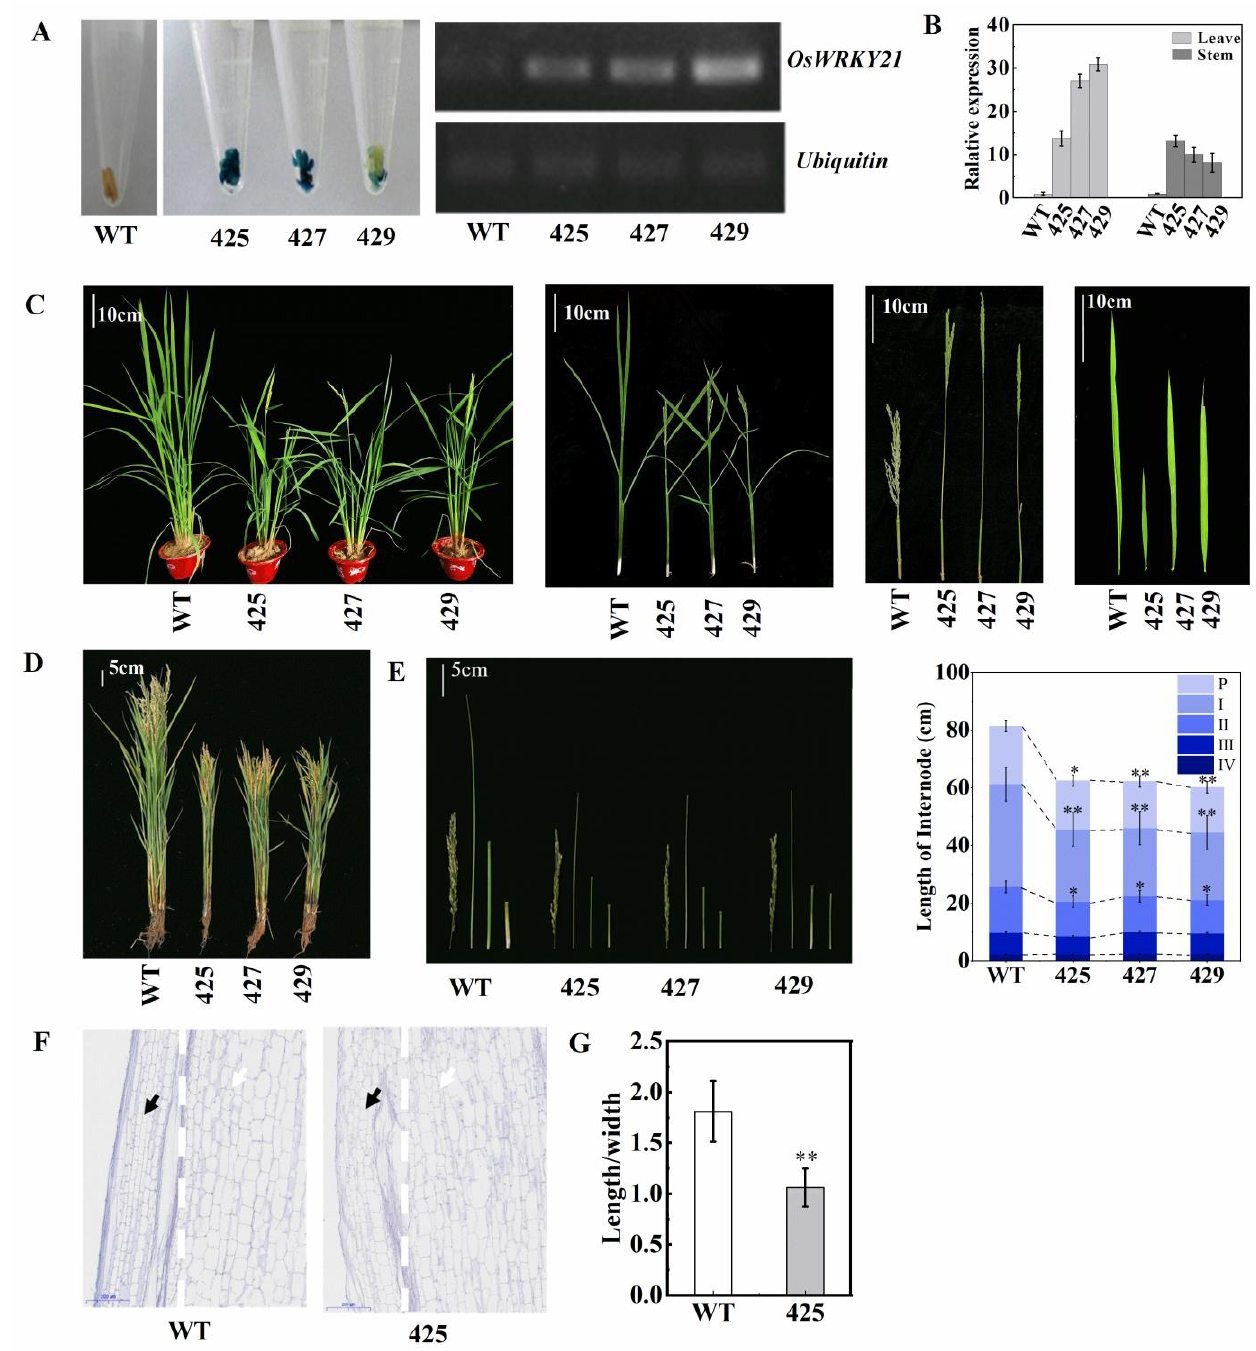
Figure 3. Generating and Characterization of OsWRKY21 transgenic plants . ( A ) GUS staining and semi-quantitative RT-PCR to select positive transgenic lines (425, 427 and 429). The positive OsWRKY21 OE lines were in blue with the GUS staining. Gene Ubiqutin was used as the internal control in RT-PCR analysis. ( B ) Relative expression of OsWRKY21 in the wild-type ZH11 and the OE plants using qRT-PCR. ( C ) Phenotypes of the wild-type ZH11 and three OE lines (425, 427 and 429) at heading stage, scale bar = 10 cm. ( D ) and ( E ) Lengths of the panicles and internodes of wild-type ZH11 and OE plants at maturity stage. P, panicle; I, the uppermost internode; II, III, IV, the second, third, and fourth internodes counted from the up to bottom, respectively. (* and ** indict p -value < 0.05 and 0.01, respectively, t -test, n = 15). ( F ) and ( G ) Comparison of the longitudinal sections of the second uppermost internodes of WT and line 425, scale bar = 200 µ m. Values of the ratios of cell length to width of WT and 425 line, values are means ± SD of 20 cells (* p < 0.05, ** p < 0.01, t -test, n = 20).